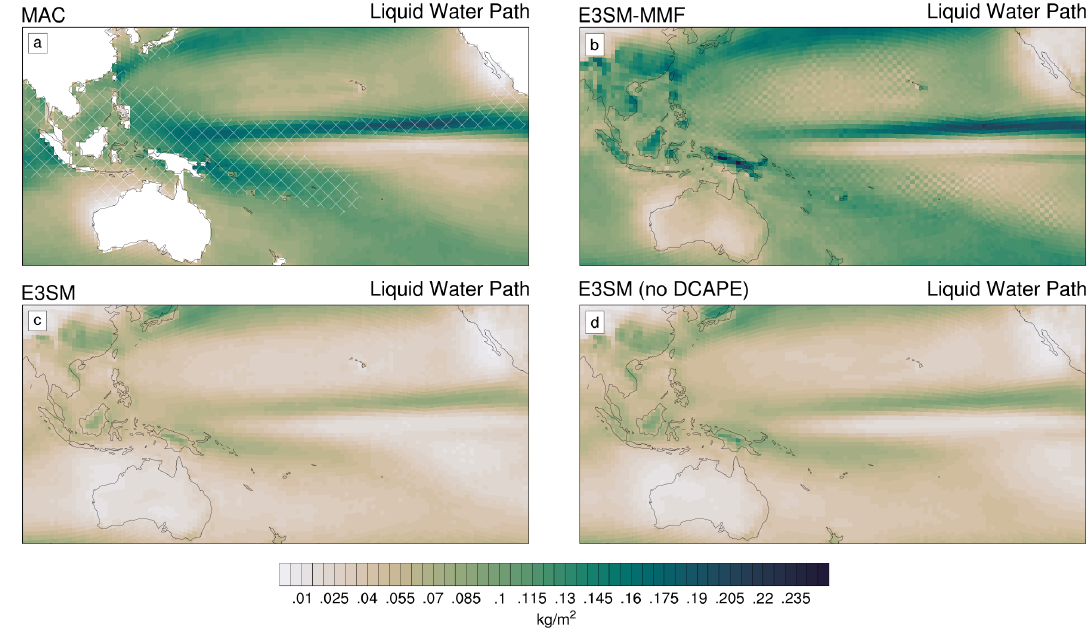
Figure 6. Maps of 5-year mean liquid water path for MAC-LWP, E3SM-MMF, E3SMv2, and E3SMv2 with the DCAPE trigger disabled. Hashing indicates regions for which MAC cloud liquid water path is more uncertain, as described in Sect.